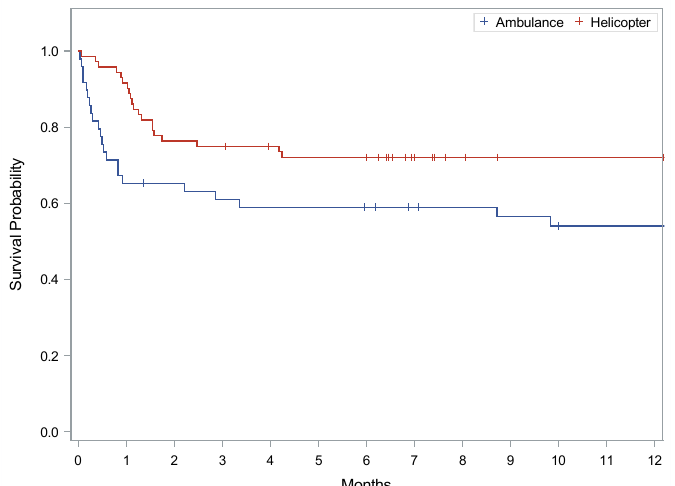
Figure 2. The Kaplan–Meier curve illustrates the survival to ICU discharge rate for patients trans- ported on ECMO. The red line represents patients transported by helicopter, and the blue line represents patients transported by ambulance. Crosses indicate censored data. Kaplan–Meier esti- mates for survival favored the helicopter cohort (79.2% to ICU discharge) rather than the ambu- lance cohort (64.0%). A Log rank test was performed, p value = 0.03. The helicopter cohort had a better pre-ECMO profile, including a decreased length of hospital stay (6.0 (2.0–9.0) vs. 8.5 (4.1–17.0) days, p value = 0.0017), a decreased length of ICU stay (3.0 (2.0–6.8) vs. 5.7 (3.0–13.0) days, p value = 0.0007), decreased days spent on MV (3.0 (1.5–5.0) vs. 5.1 (3.0–12.5) days, p value = 0.0002), higher RESP scores (2.3 ± 2.6 vs. 0.3 ± 3.2, p value = 0.0004), and lower ECMOnet scores (5.6 ± 1.6 vs. 6.6 ± 1.4, p value = 0.0432). All of these factors are predictive of higher survival probabilities. T-tests per- formed for additional pre-ECMO predictive factors did not show statistically significant differences between the two cohorts, including in age, BMI, SAPS-II score, SOFA score, Murray score, Charlson score, PRESERVE score, P/F ratio, and creatinine. Through univariate analysis, the following pre-ECMO values were associated with survival: prone positioning (OR 5.031, p value = 0.0031); nitric oxide administration (OR 3.750, p value = 0.0142); length of hospital stay (OR 1.050, p value = 0.0295); length of ICU stay (1.064, p value = 0.0370); and duration of MV use pre-ECMO (OR 1.077, p value = 0.0179). Postcannulation factors include AKI (OR 7.800, p value 0.0014), CRRT (OR 10.673, p value < 0.0001), the number of platelet transfusions (OR 5.000, p value = 0.0002), units of packed red blood cells (OR 1.035, p value = 0.0164), the duration of ECMO support (OR 1.008, p value = 0.0003), the duration of MV use post-ECMO (OR 0.861, p value = 0.0006), increased distance transported (OR 0.995, p value = 0.0108), and increased mission dura- tion (OR 0.830, p value = 0.0265) (Table 3). Table 3. Logistic regression of the association between predictive factors and mortality. 95%